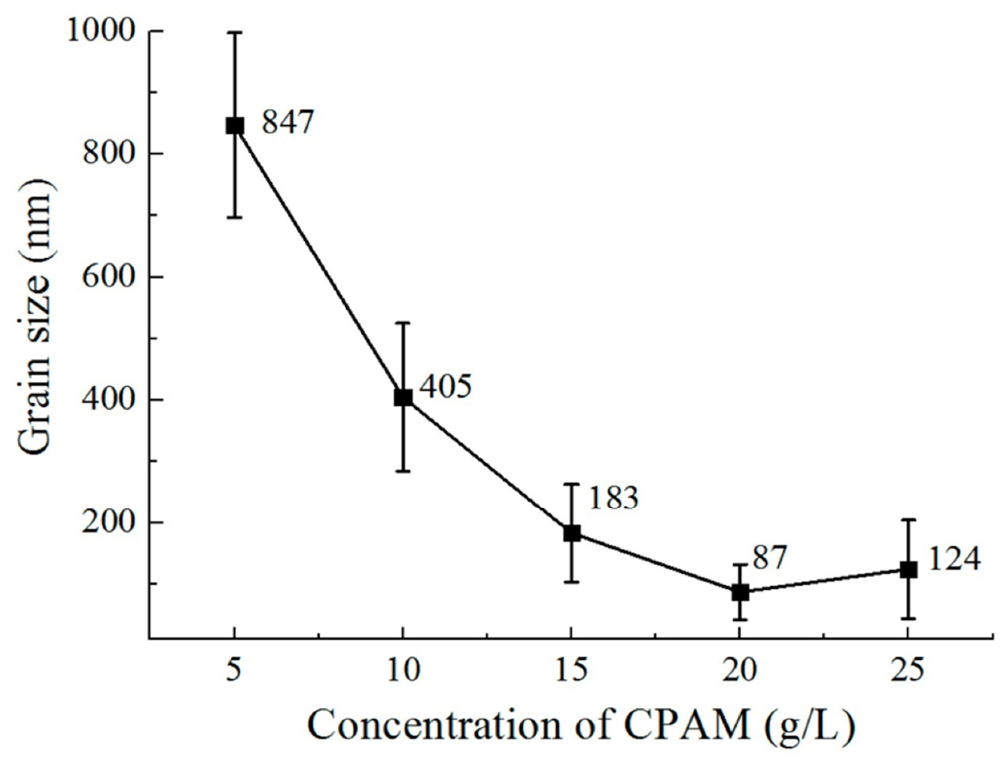
Figure 7. Variation in grain size in nanocrystalline zinc coatings with concentration of CPAM [102].